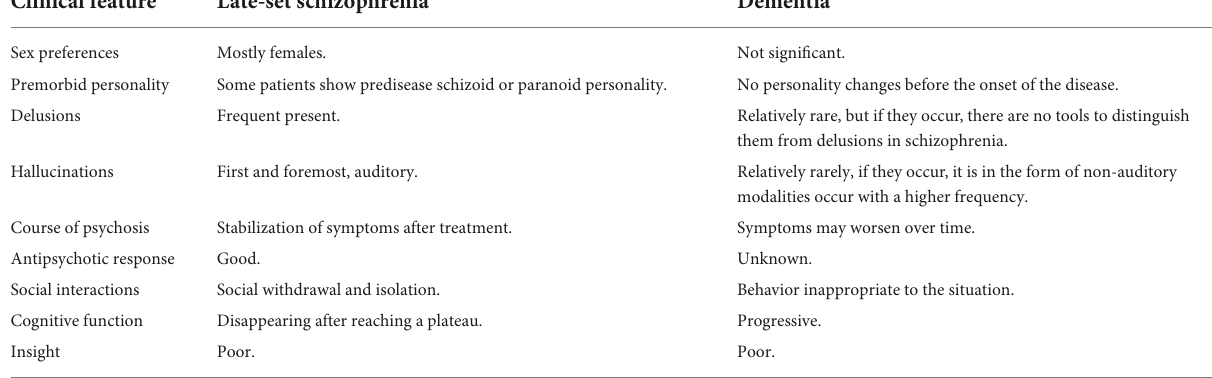
TABLE 1 Clinical characteristics of late-onset schizophrenia (LOS) vs. dementia.